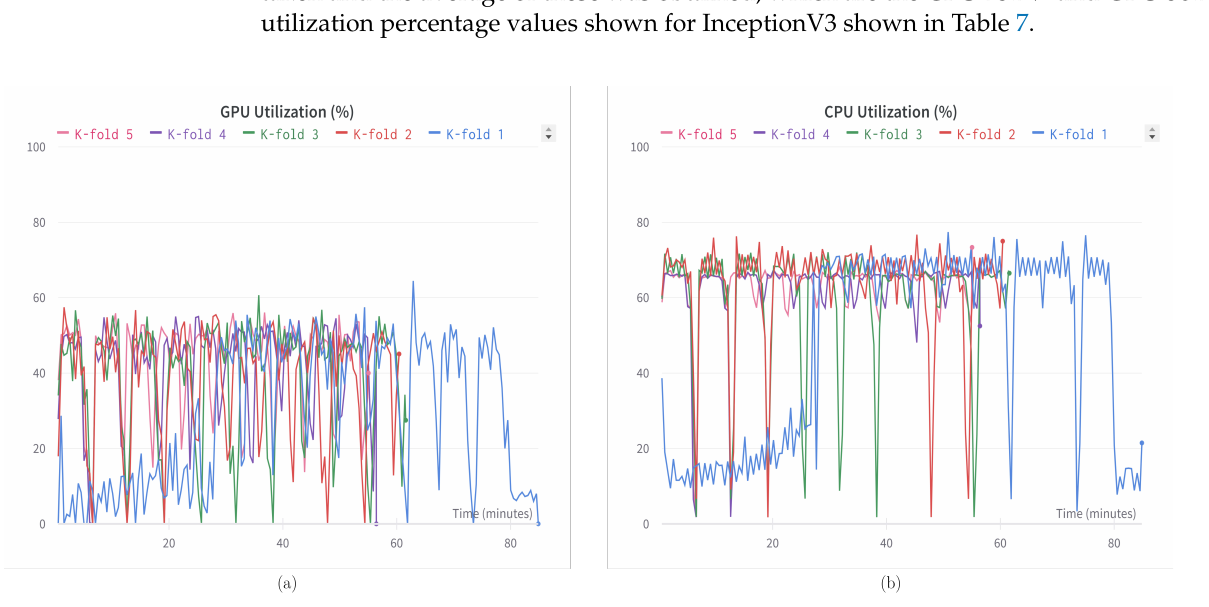
Figure 14. Computational resources used in InceptionV3 model: ( a ) GPU utilization percentage graph for InceptionV3 model; ( b ) CPU utilization percentage graph for InceptionV3